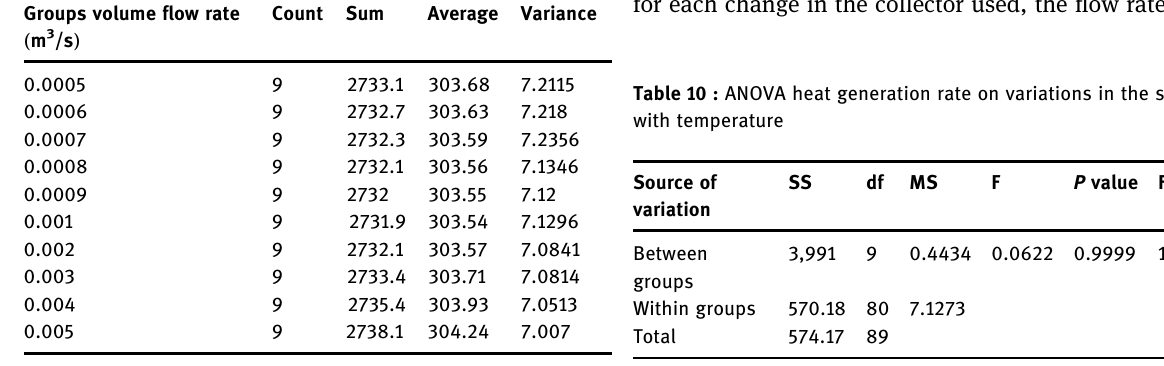
Table 9 : Summary data on the heat generation rate results of variations in the shape with temperature Groups volume fl ow rate ( m 3 /s )